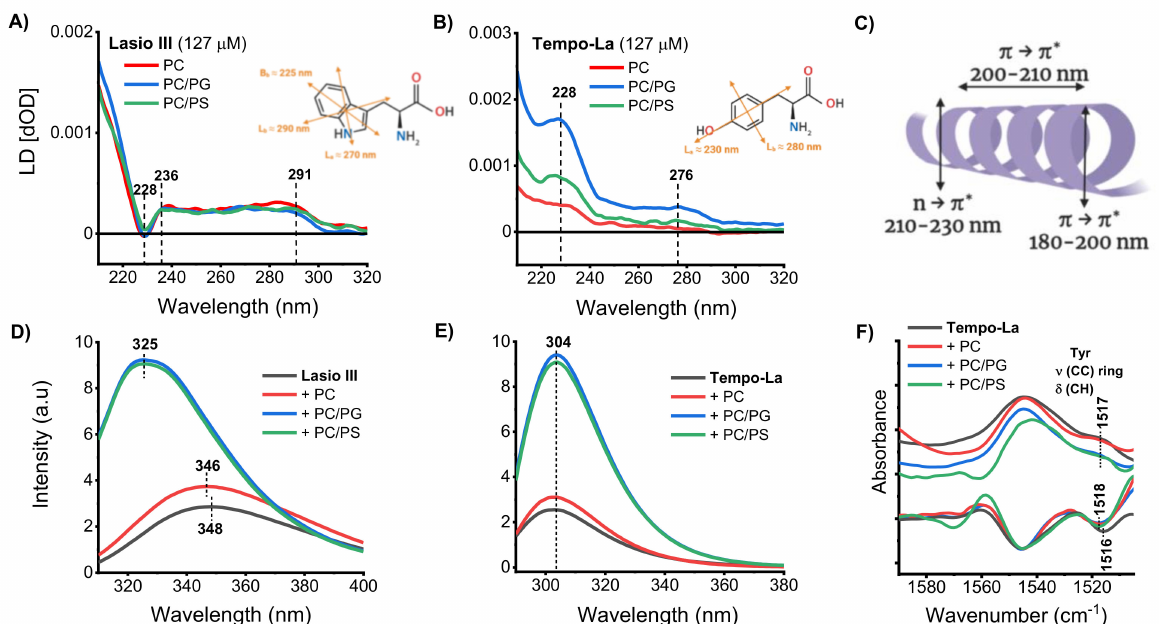
Figure 3. Peptide orientation upon binding to lipid membrane. ( A , B ) LD spectra of Lasio III ( A ) and Tempo-La ( B ) in the presence of the model membranes PC, PC/PG, and PC/PS. Spectra were collected at 1.27 mM lipid concentration. ( C ) Schematic representation of the transitions moment directions of an α -helical peptide secondary structure. ( D , E ) Fluorescence emission spectra of Lasio III (Trp fluorophore, excited at 295 nm) ( D ) and Tempo-La (Tyr fluorophore, excited at 275 nm) ( E ) in the presence and absence of model membranes. Peptide and lipid concentrations were 2 and 100 µ M, respectively. ( F ) IR analysis of the tyrosine band of Tempo-La alone and in the presence of lipid membranes, showing the Tyr vibration band region. Second derivative is shown below and was used for peak identification. Peptide and lipid concentrations were 80 µ M and 1.27 mM,